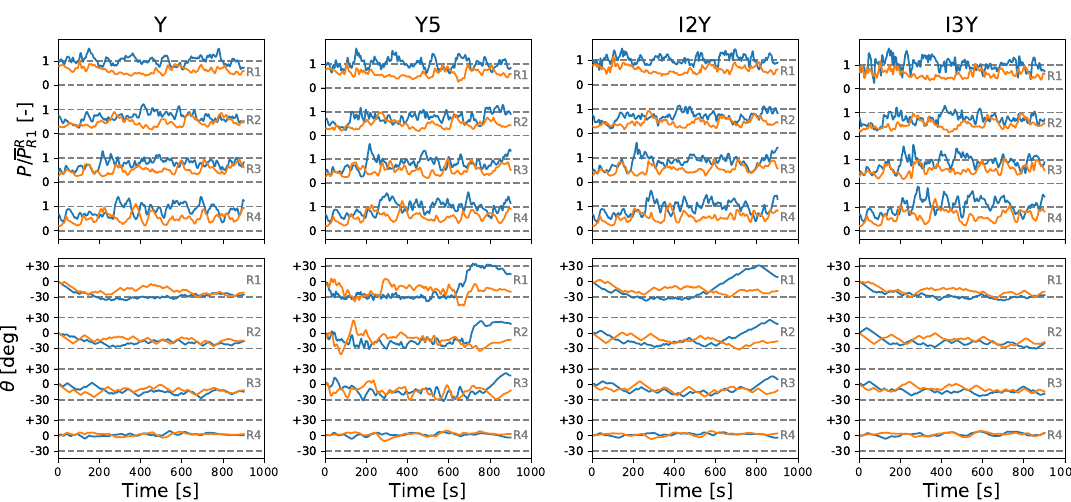
Figure 13. Time evolution of turbulent inflow yaw-enabled cases for columns C2 and C4. Top: Turbine power extraction P , normalized by mean first row power in the uncontrolled reference P Yaw angle θ . Every line represents a single wind turbine. Line colors indicate different turbine columns defined in Figure 3: The blue lines are for C2 and the orange lines are for